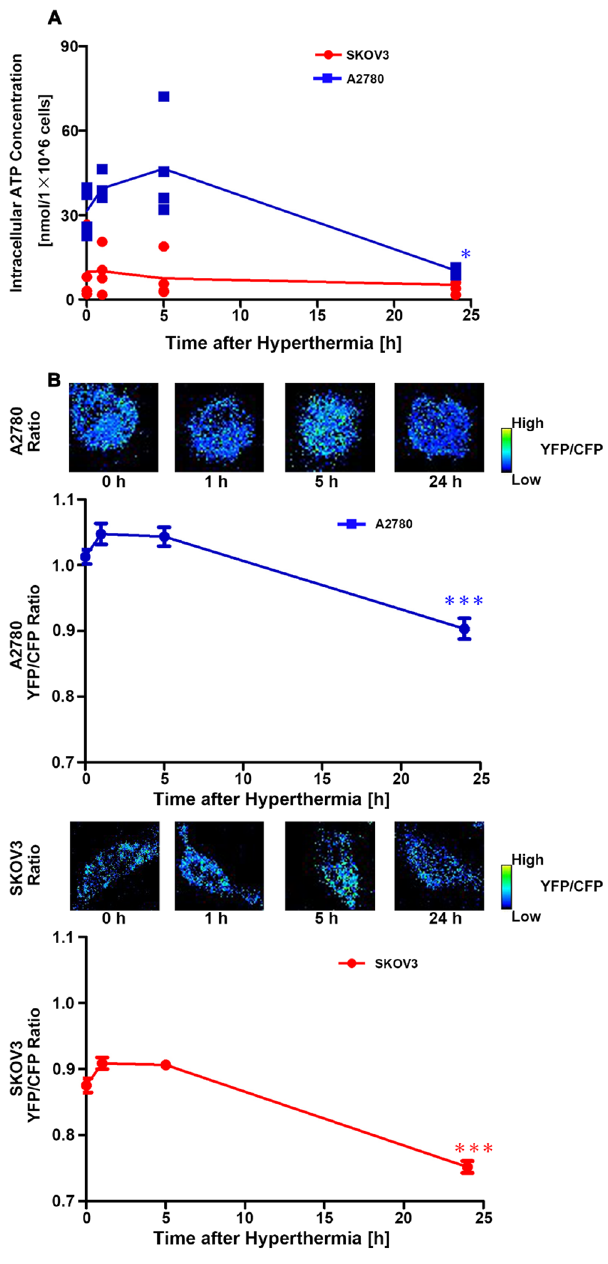
Figure 4. Quantification of intracellular ATP in A2780 and SKOV3 cells treated with hyperthermia. ( A ) Time profiles of ATP concentrations in A2780 and SKOV3 cells. Cells were treated with hyperthermia at 46 °C for 1 h (between 0 and 1 h) and then incubated at 37 °C until indicated time points. Intracellular ATP was quantified with CE-TOFMS. Means and observation points were plotted. Monitoring of cytoplasmic ATP levels of A2780 (upper) and SKOV3 (lower) cells using AT1.03. Cells that were transfected with AT1.03 were treated with hyperthermia at 46 °C for 1 h (between 0 and 1 h) and then incubated at 37 °C until indicated time points. Sequential wide-field images of YFP/CFP emission ratio and time courses of averaged YFP/CFP emission ratio of A2780 (upper) and SKOV3 (lower) cells expressing AT1.03. Mean ± S.E. (n = 40). *P < 0.05; ***P < 0.001 (vs 0